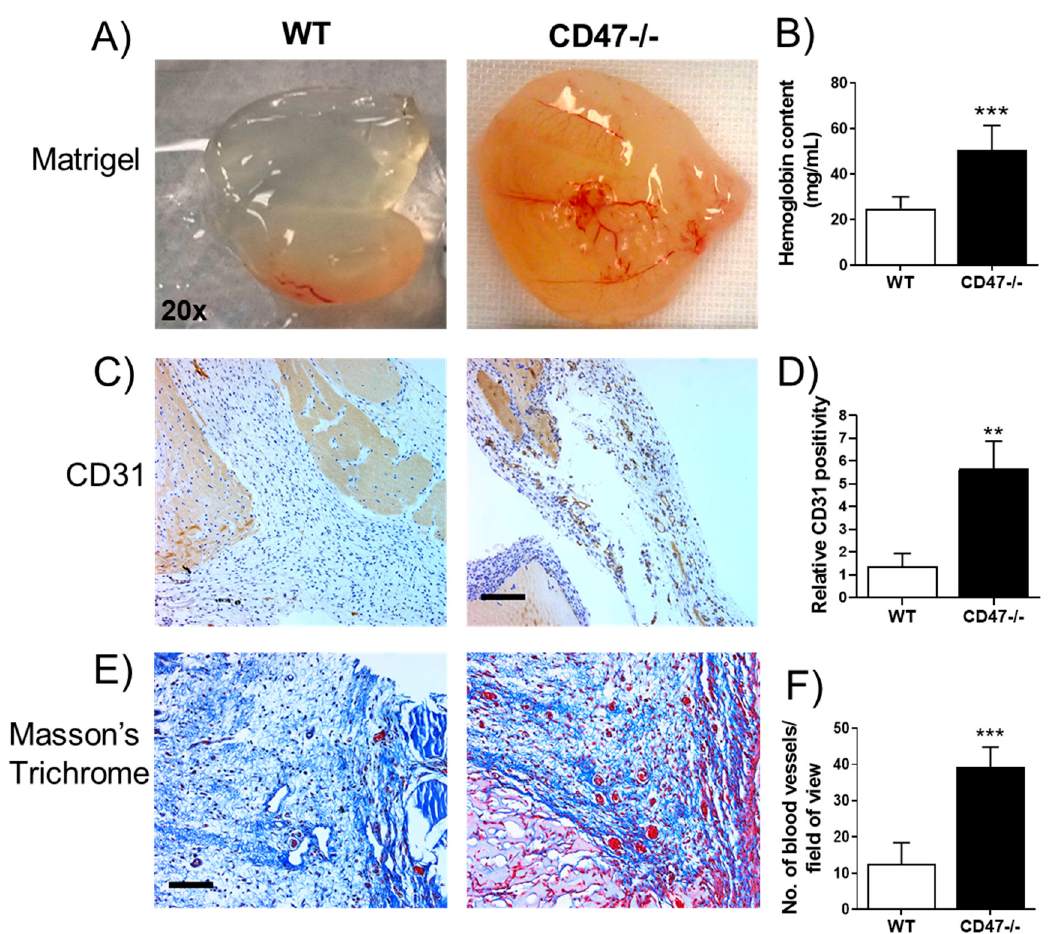
Figure 5. CD47 suppresses in vivo angiogenesis in aged mice. Inspection of angiogenesis ( A ), Matrigel plug hemoglobin content ( B ) and CD31 expression and quantification ( C , D ). Quantification of blood vessels in Matrigel plugs obtained from aged CD47-null compared to aged wild-type (WT) mice ( E , F ). Representative whole Matrigel plug images (20 × magnification), n = 6 / group. Scale bar: 100 µ m. Error bars represent the mean ± SEM. An unpaired t -test performed with ** p < 0.01, *** p < 0.001, ns: non-significant.